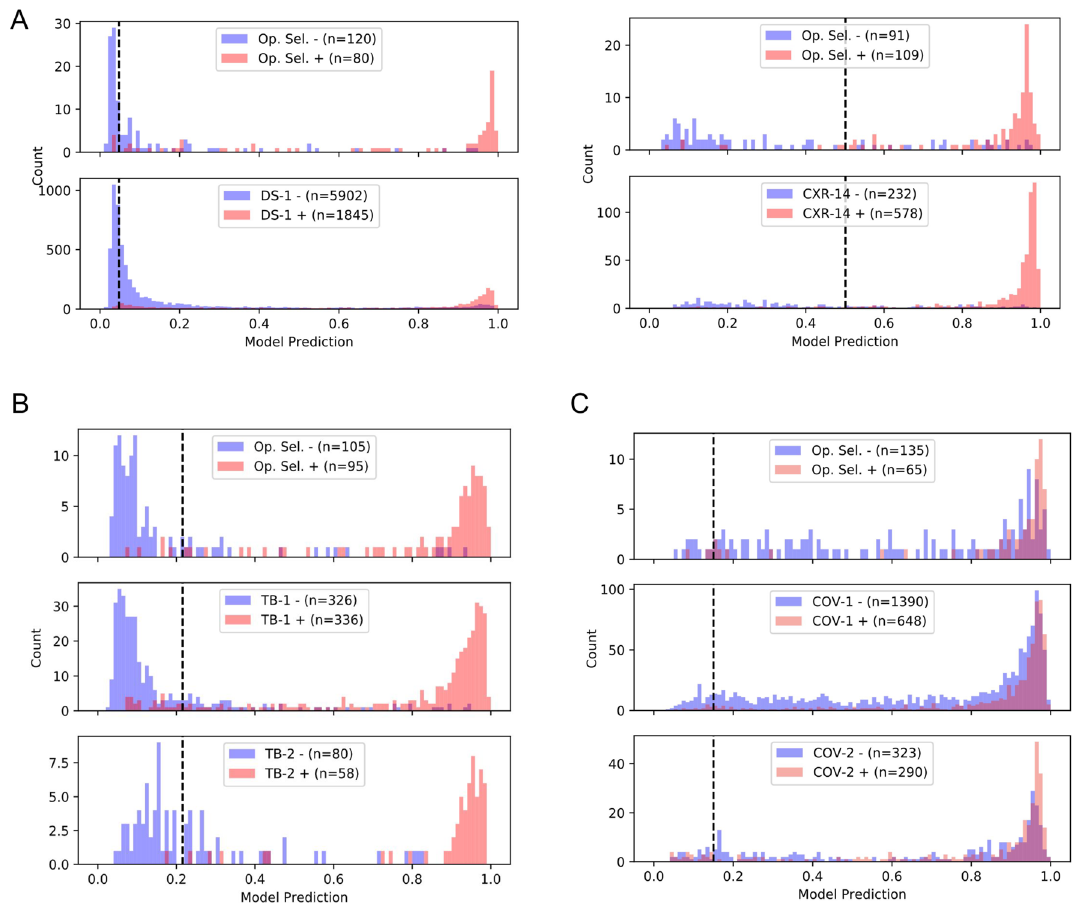
Figure 4. Histogram for the distribution of DLS predicted scores across 6 datasets and their corresponding operating point selection sets: ( A ) DS-1 and CXR-14, ( B ) TB-1 and TB-2, and ( C ) COV-1 and COV-2. Curation of the operating point selection (Op. Sel.) datasets is described in “Operating point selection datasets” in “Methods”. Positive and negative examples are visualized separately in red and blue, respectively. The vertical lines (black) highlight the selected high-sensitivity operating point for each